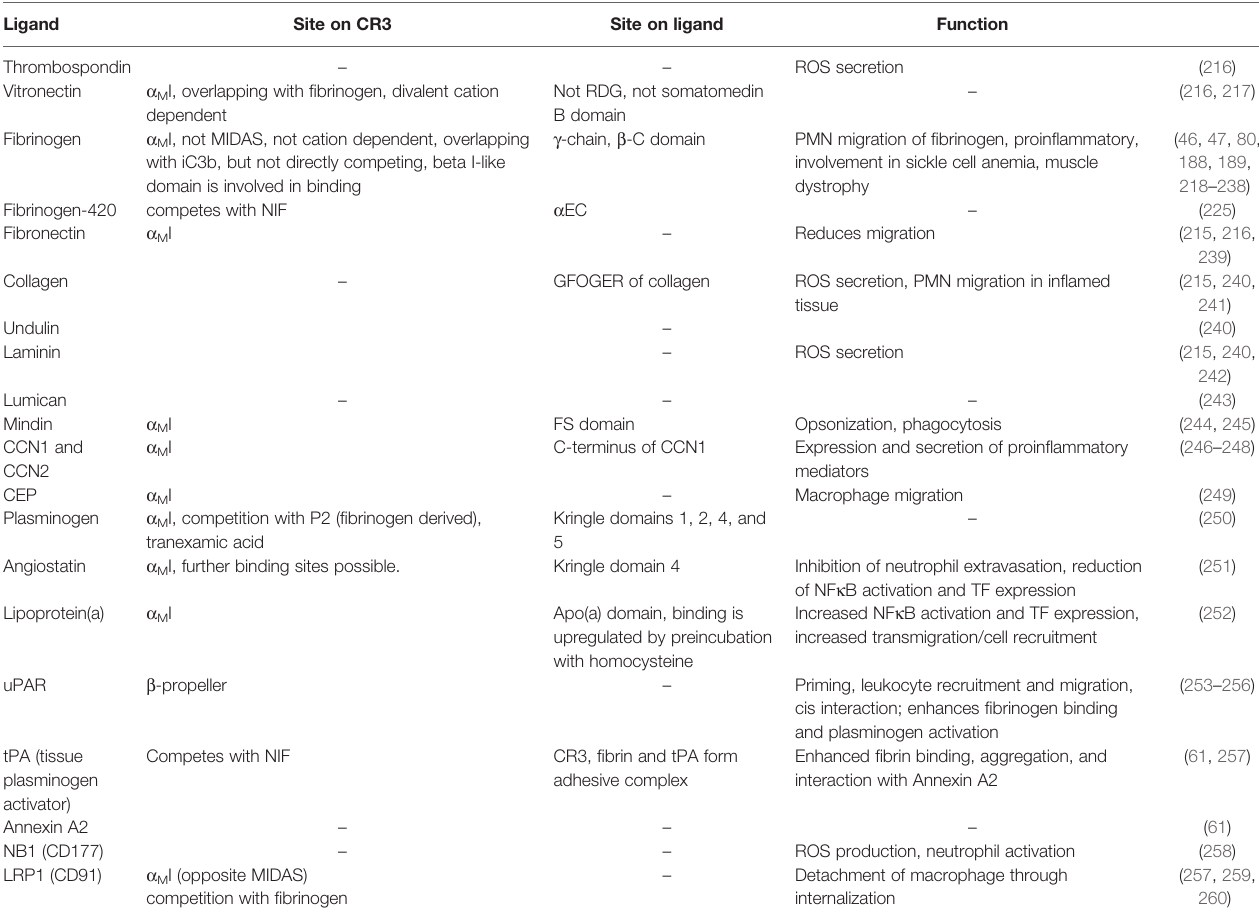
TABLE 6 | Leukocyte migration on extracellular